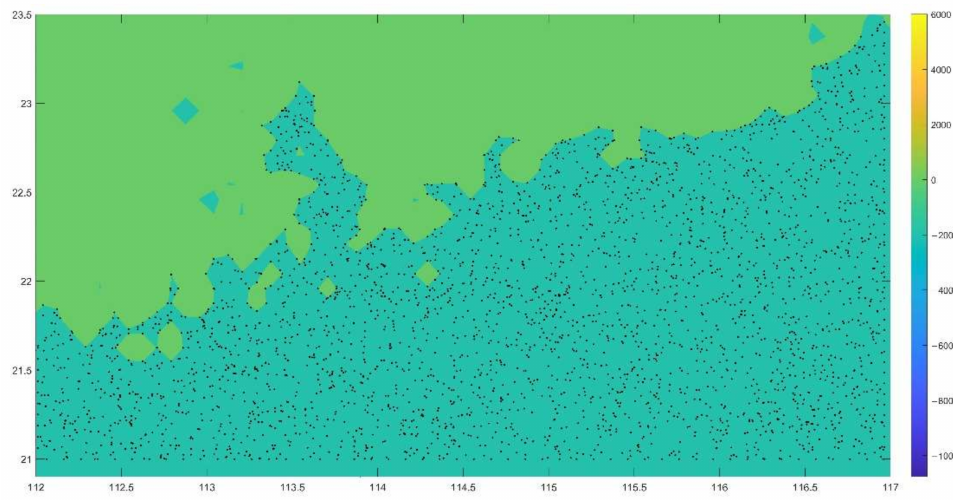
Figure 10. Nodes within the South China Sea inlet.